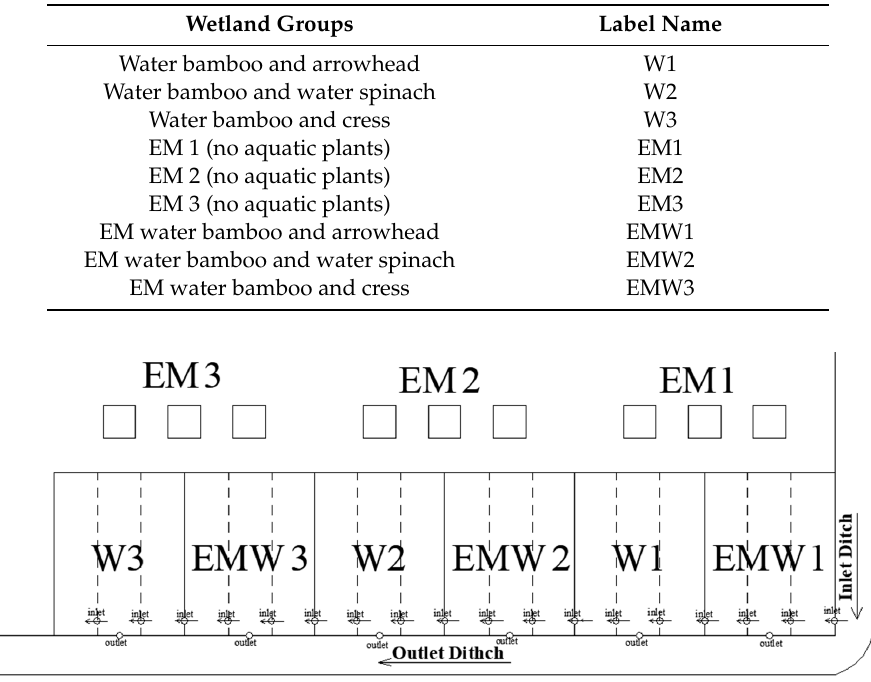
Figure 1. The layout of wetland cells.